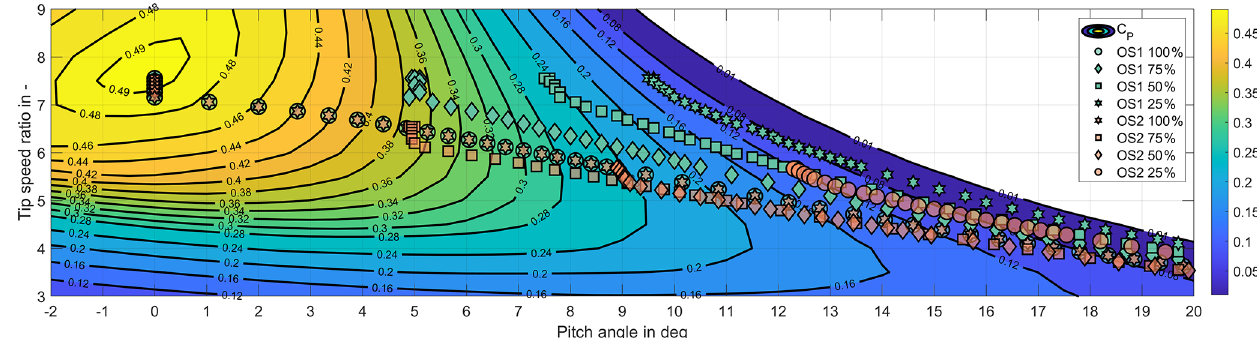
Figure 1. Linearization points on the power coefficient surface for the strategies OS1 and OS2.